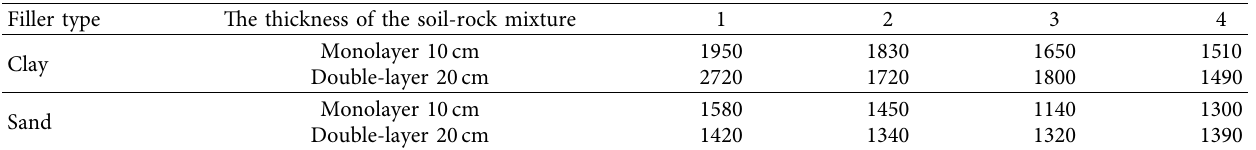
Figure 11: Sand matrix, double-layer stone test results. (a) Test 4-1. (b) Test 4-2. (c) Test 4-3. (d) Test 4-4. Table 4: Tensile force representative value ( N ) of pull-out test.